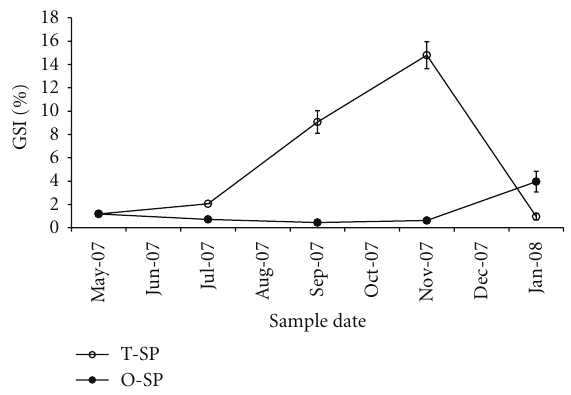
Figure 2: Change of the gonadosomatic index (GSI) of rainbow trout females through their gonadal reproduction cycle. O-SP: once spawners; T-SP: twice spawners (mean ± SE, n = 4).